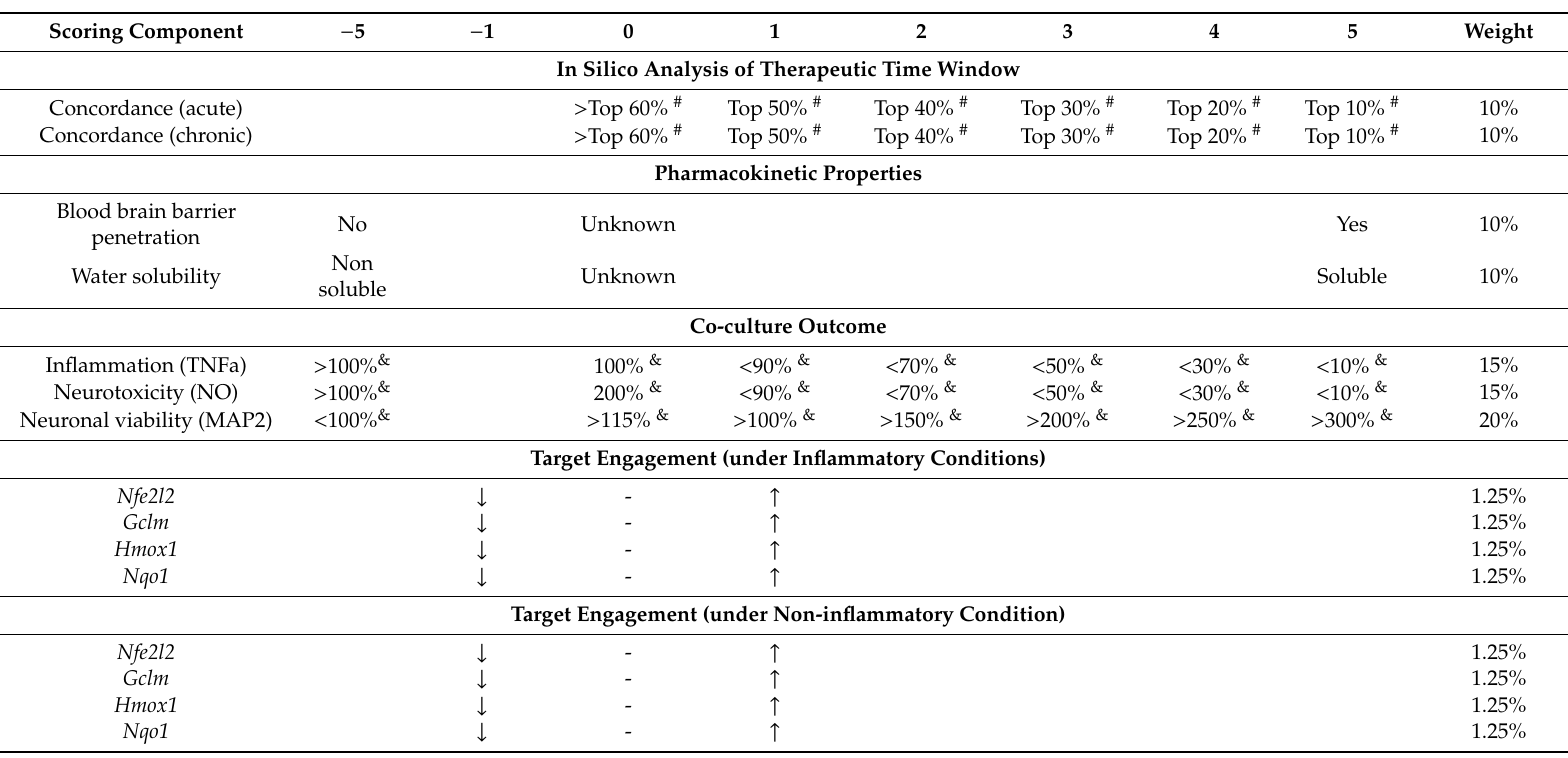
Table 5. Weighted scoring of compound performance based on in silico and in vitro analysis to facilitate compound selection for in vivo validation. Scoring Component − 5 − 1 In Silico Analysis of Therapeutic Time Window Concordance